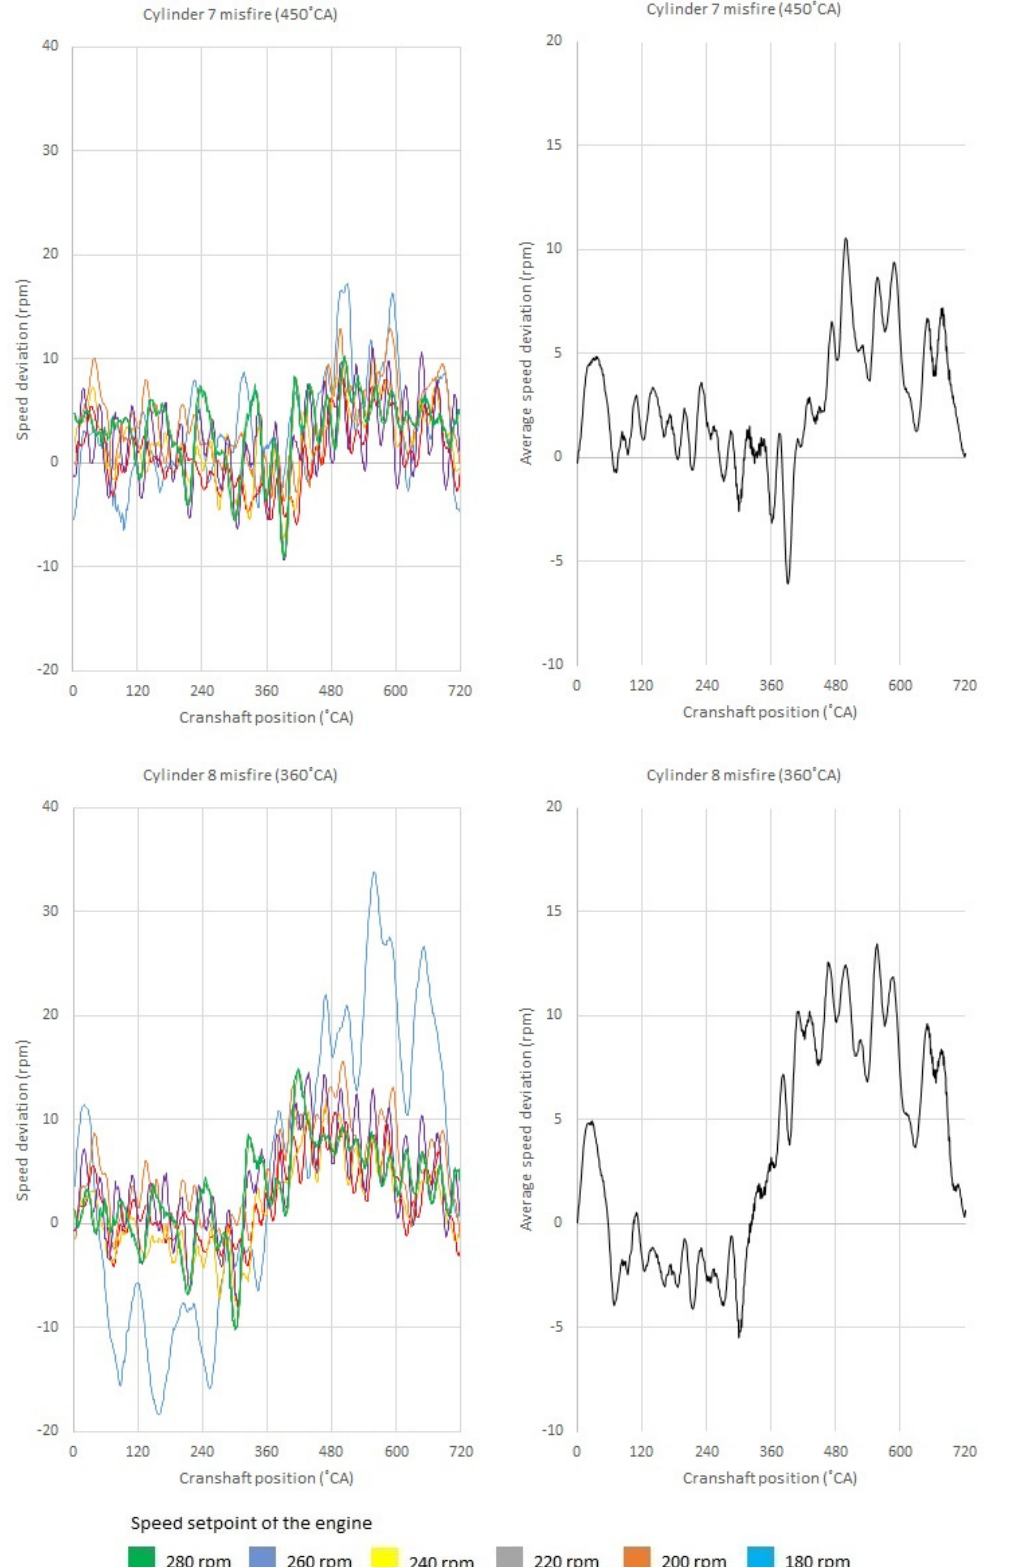
Figure 18. Instantaneous speed differences and the average deviation of the combustion loss in cylinders 7 and 8 of the Buckau-Wolf R8DV-136 engine.